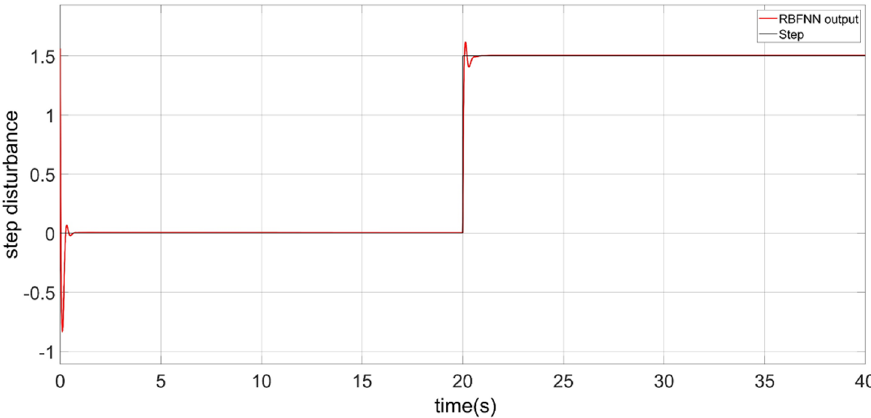
Figure 16. The output of the yaw angular velocity RBFNN. At 20 s, the acceleration of the yaw angle was subjected to a step disturbance of 1.5.